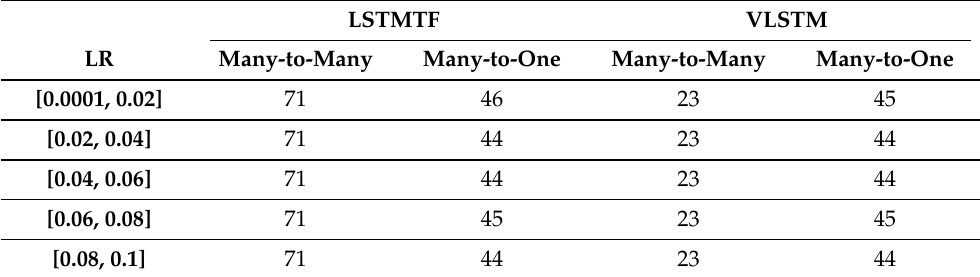
Table 7. The training convergence time (epochs) for LSTMTF and VLSTM, computed with respect to the learning rate, for (cid:101) = 1% and P = 5.